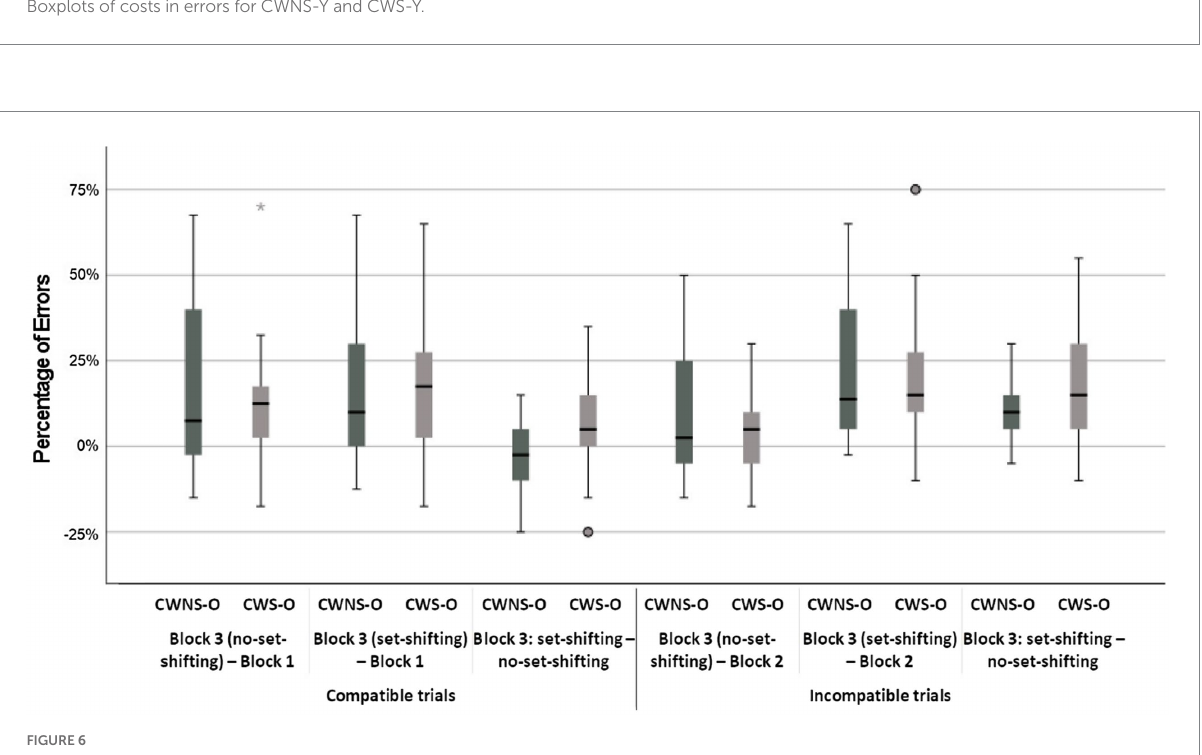
FIGURE 6 Boxplots of costs in errors for CWNS-O and